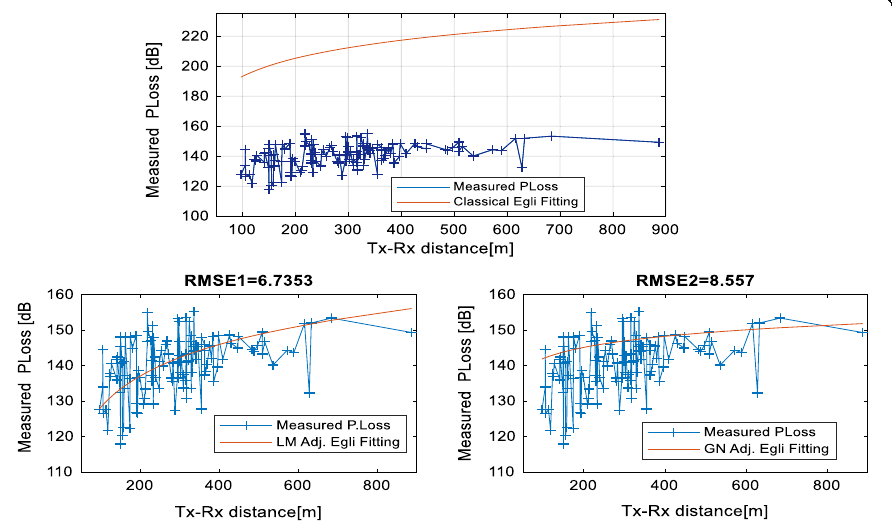
Fig. 7 Measured propagation loss estimation and their error distribution statistics using classical Egli model and adapted Egli model for